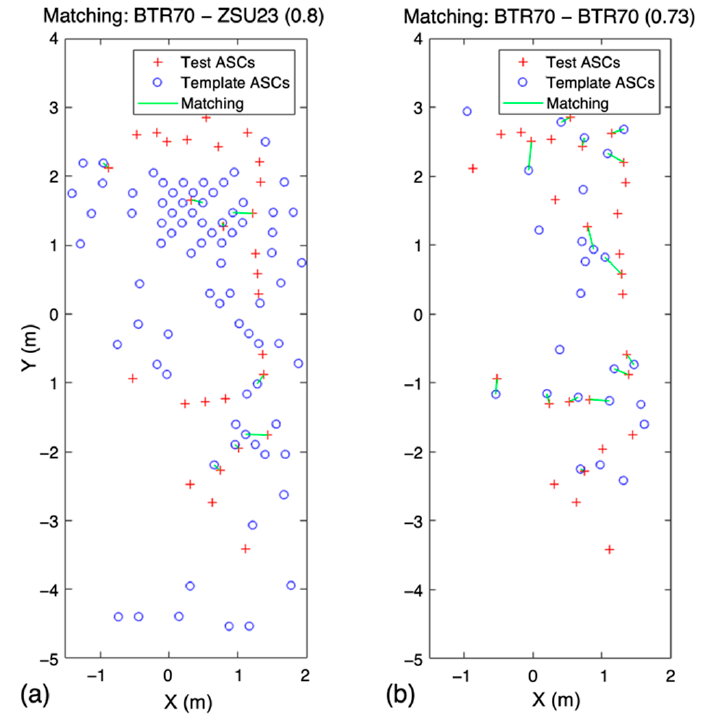
Figure 6. WVV-based similarity matching results between two sets of scattering centers. ( a ) Different types of test and template SCs, ( b ) same target type of test and template SCs.